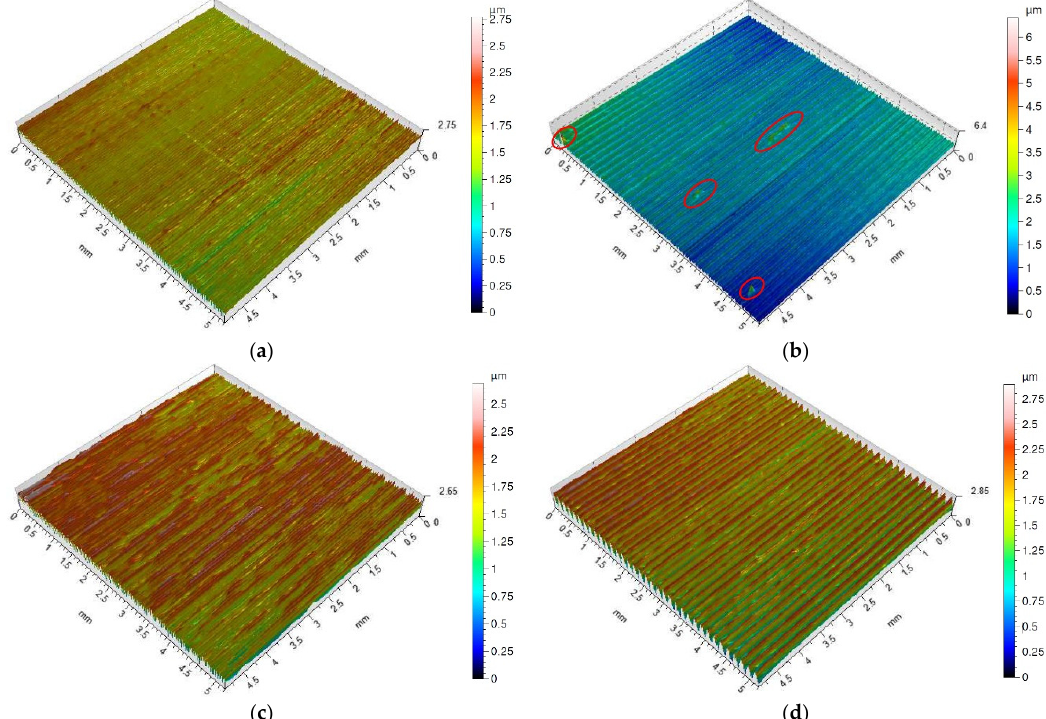
Figure 13. Surface topography of Inconel 718 after turning by the Wiper insert (the sticking on machined surface is marked by red circle). ( a ) dry cutting, f = 0.05 mm/rev; ( b ) dry cutting, f = 0.15 mm/rev; ( c ) wet cutting, f = 0.05 mm/rev; ( d ) wet cutting, f = 0.15 mm/rev.